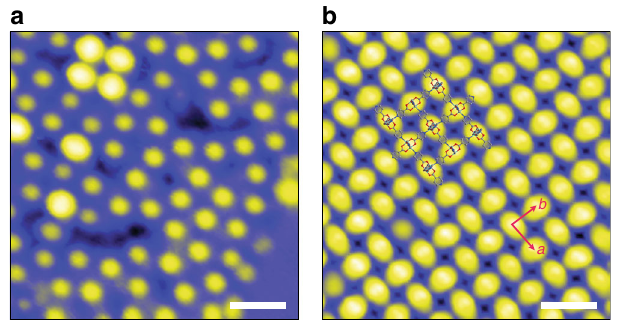
Fig. 5 STM topography images of a Mo 2 (INA) 4 monolayer on a Au(111) surface. a STM image (bias V = 0.05 V, tunneling current I = 5 pA) of Mo 2 (INA) 4 clusters deposited on Au(111) before annealing. Scale: 2.0 nm. b STM image ( V = 2 V, I = 10 pA) of a 2D Mo 2 (INA) 4 MOF monolayer on Au(111) after annealing (crystal structure 2 is superimposed). Scale: 2.0